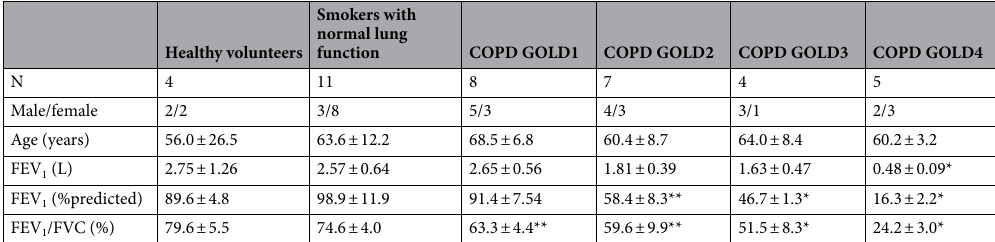
Table 1. COPD study patient characteristics for lung study. Data are expressed as mean values ± SD. * P < 0.05; ** P < 0.01 versus healthy